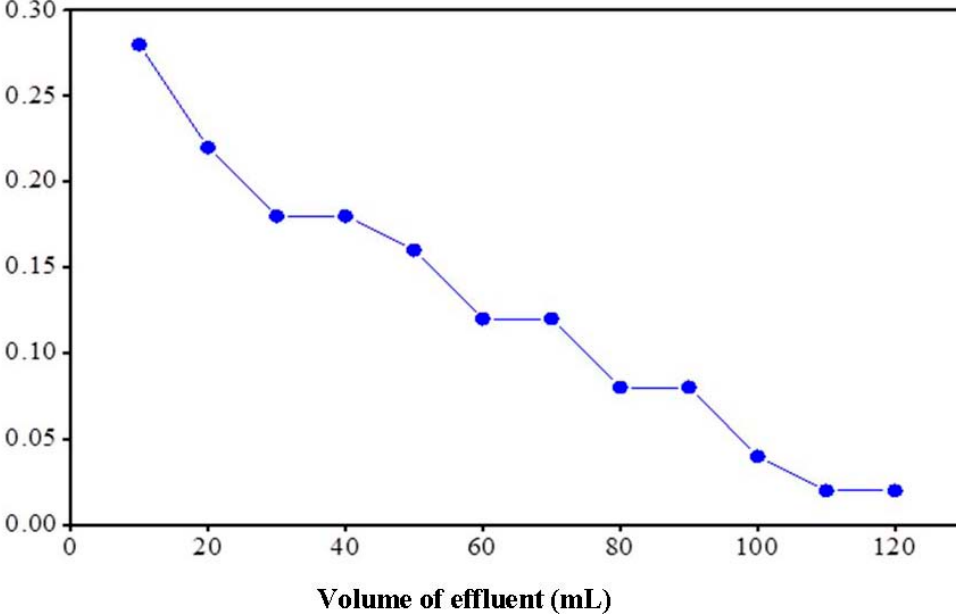
Figure 4. Elution behavior of graphene Th(IV) phosphate cation-exchange material.